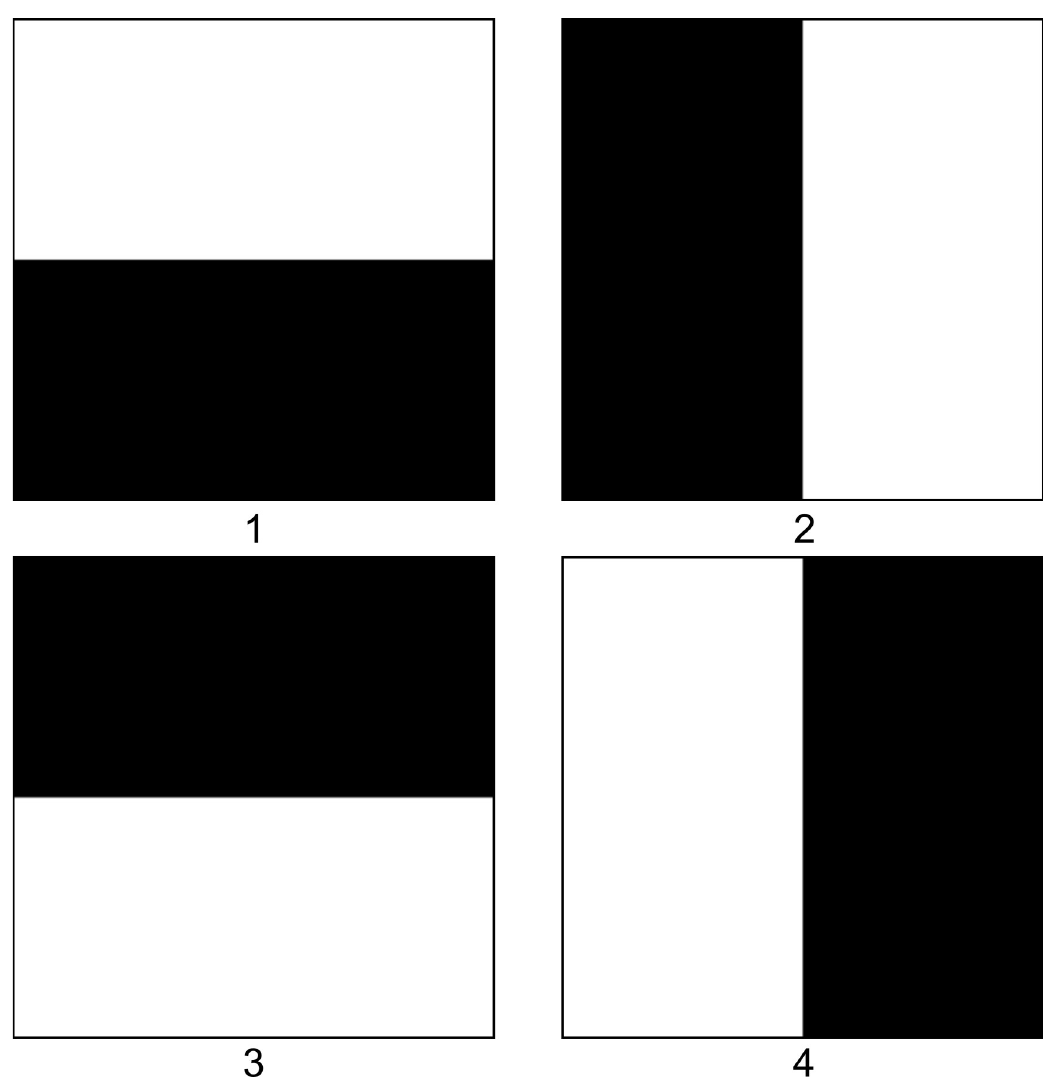
Fig 2. Four half-white (pixel values = 1) and half-black (pixel values = 0) 256 * 256 pixel images evaluated by POSEA. For each image, the white area was considered the segmented region. Each image was evaluated against the other image, including its